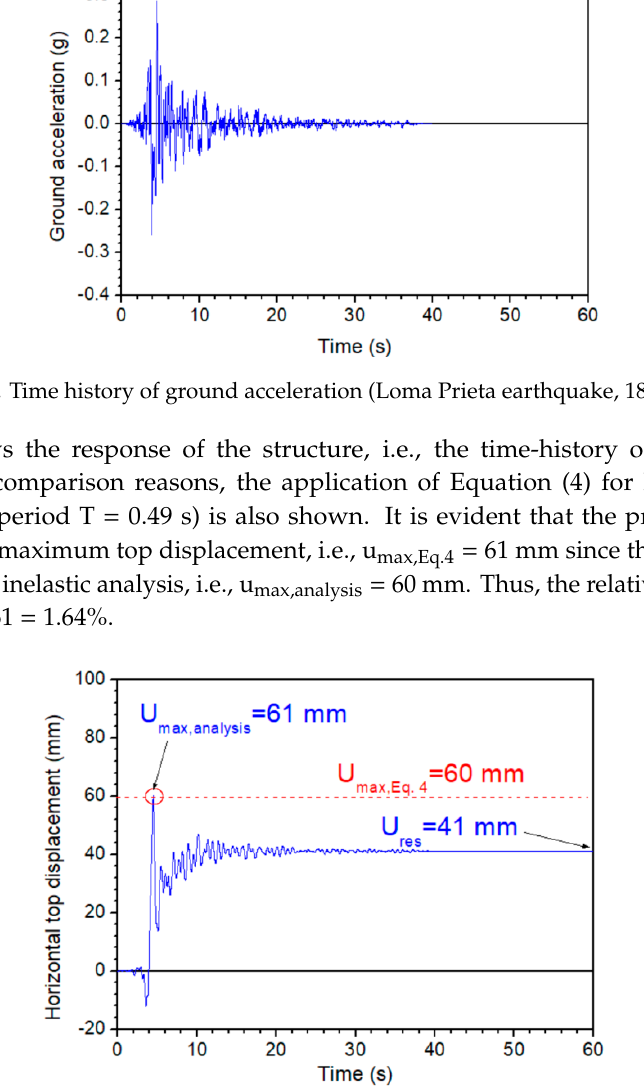
Figure 15. Time history of top displacement of Frame B1 under the Loma Prieta (18/10/1989) earthquake.